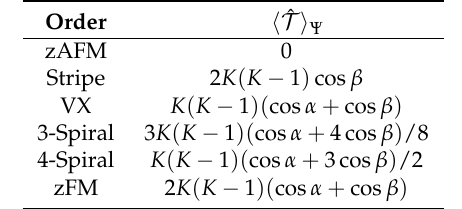
Table 1. Expectation of the hopping operator and the steady-state photon number for different phases in the Mott insulator (MI)